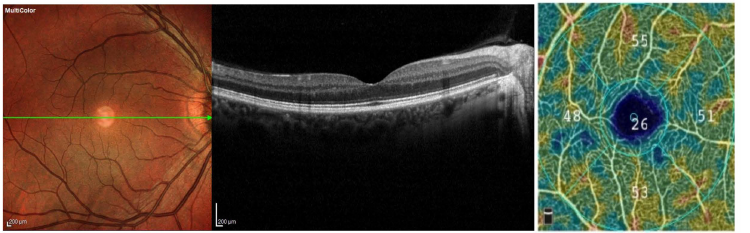
Figure 2. Multimodal retinal imaging of a healthy eye of 65-year-old. On OCTA scan foveal and parafoveal vessel density values are